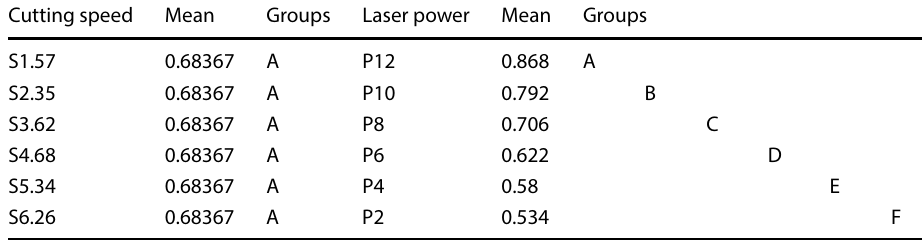
Table 32 Cutting speed and laser power